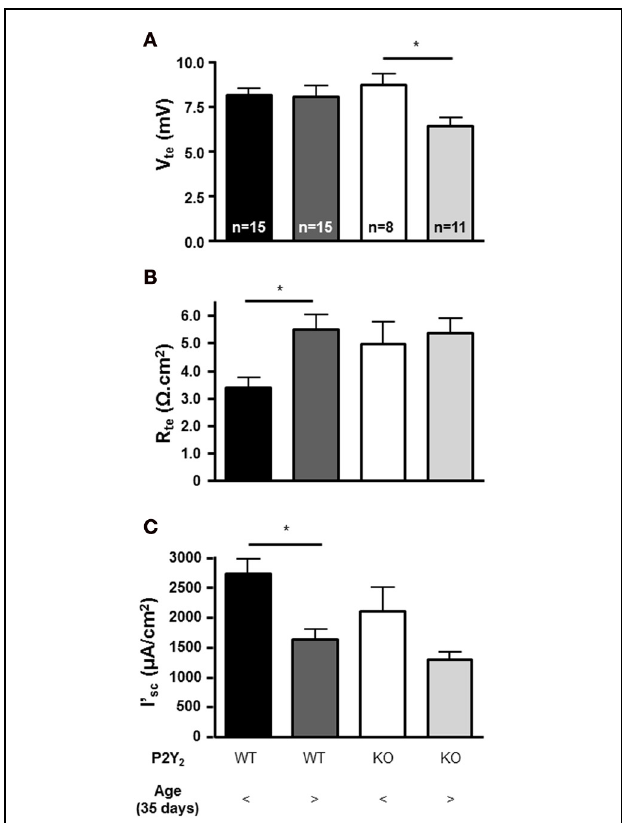
FIGURE 3 | Ion transport parameters in mTALs (A: V te , B: R te , and C: I’ sc ) from juvenile (25–35 days) and adult (35–55 days) P2Y 2 receptor WT and KO mice (*statistical significance p < 0 . 05).